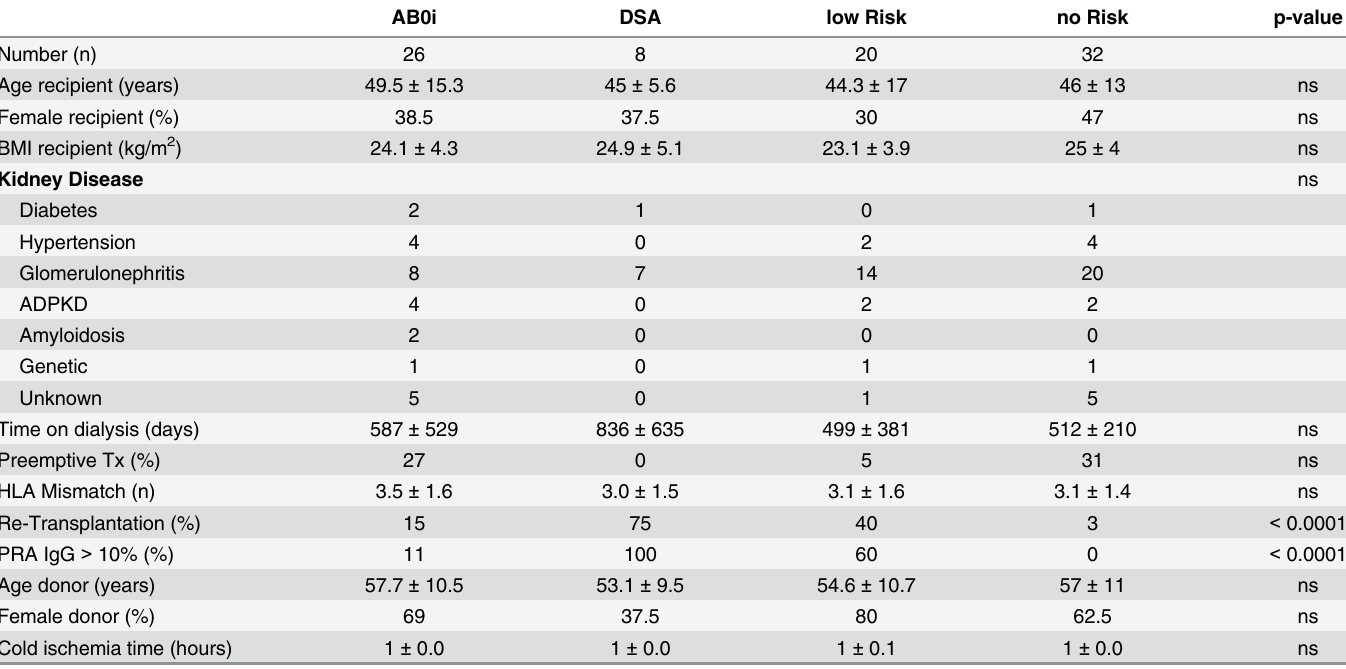
Table 2. Patient and donor